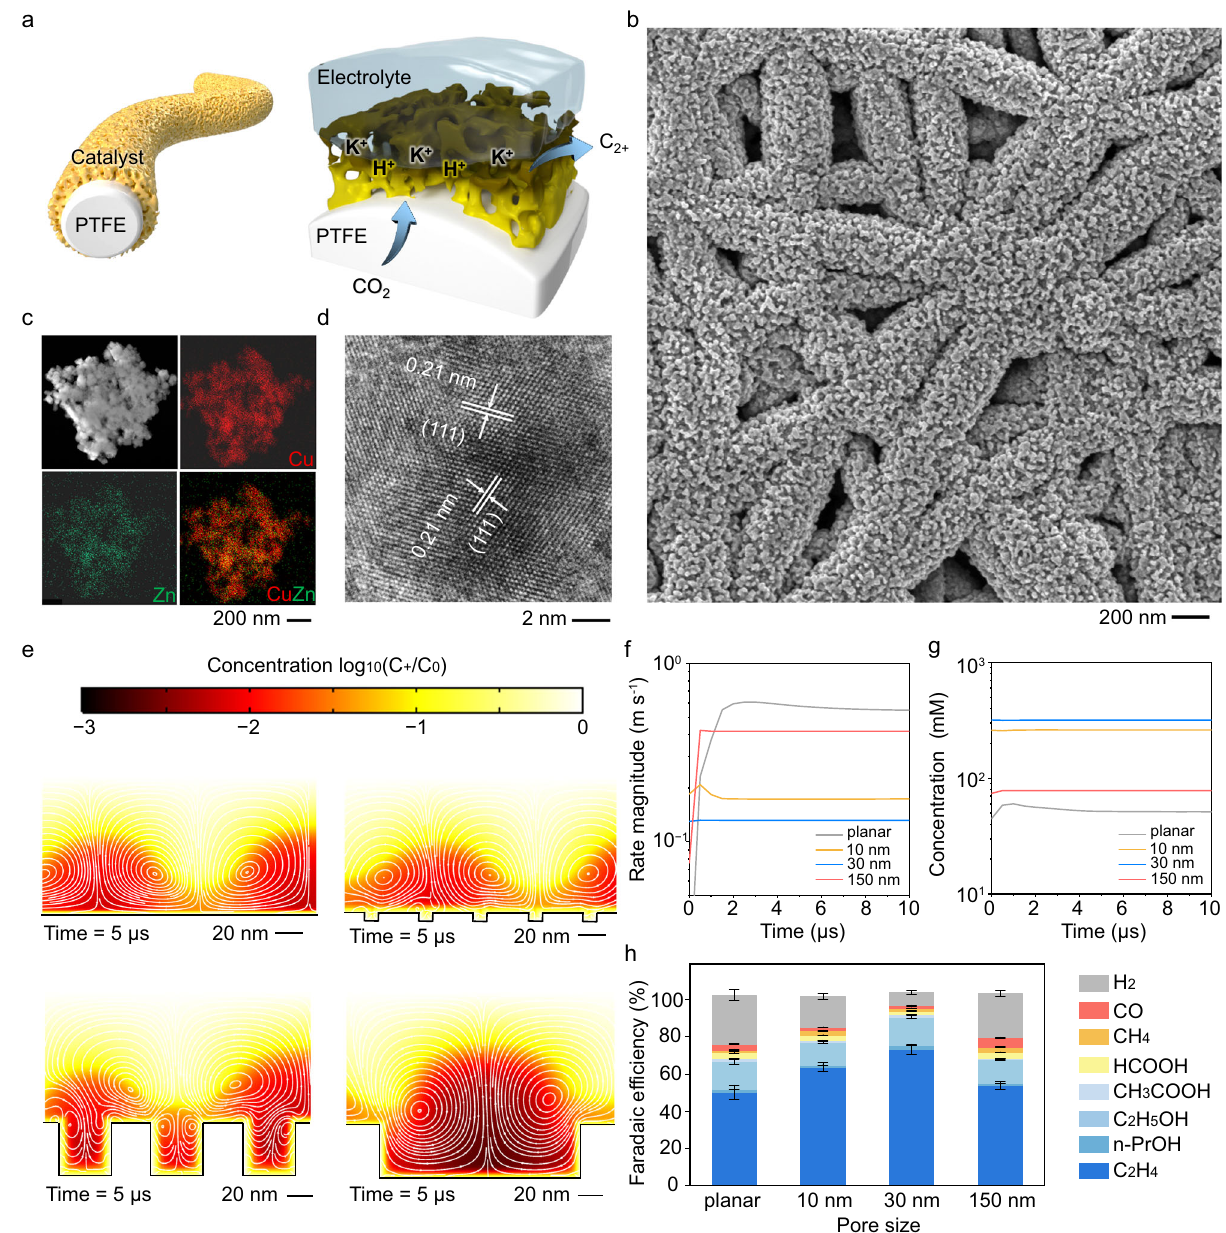
Fig. 3 | Characterisation and performance of nanoporous Cu 0.9 Zn 0.1 catalysts fabricated by co-sputtering and wet-chemical-etching. a Schematic of nano- porous Cu 0.9 Zn 0.1 forelectrochemicalCO 2 R. b SEMimagesof nanoporous(30nm) Cu 0.9 Zn 0.1 . c STEM and EDS and d HRTEM images of Cu 0.9 Zn 0.1 . e Simulated ion concentrations and electro-kinetic fl ows near the planar and nanoporous (10, 30,